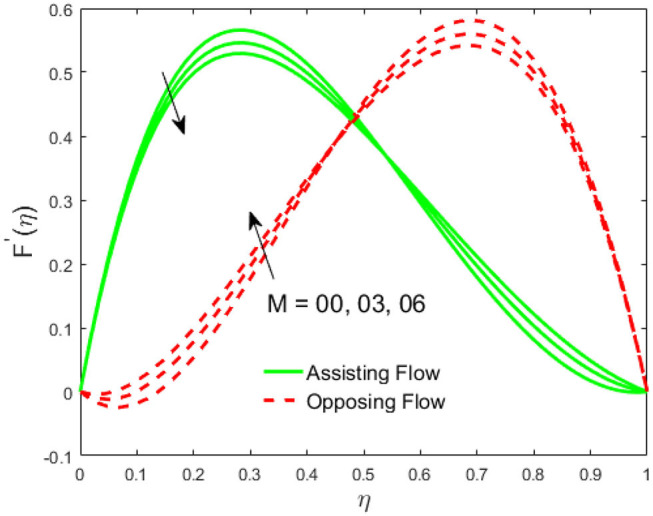
Impact of M on F′(η).